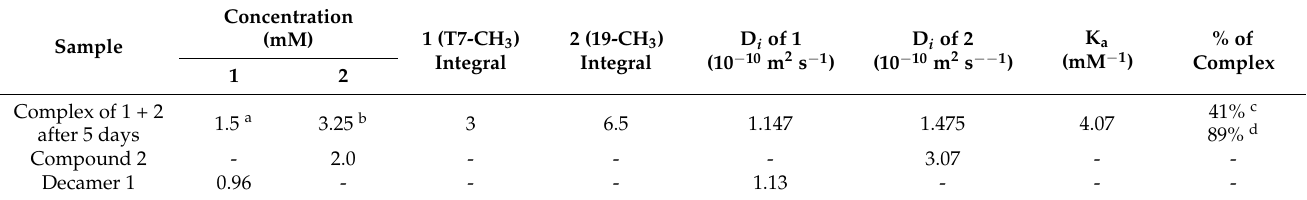
Table 1. The diffusion constants Di × 10 − 10 (m 2 s − 1 ) and binding constant calculation of a complex 1 + 2 from the DOSY data.